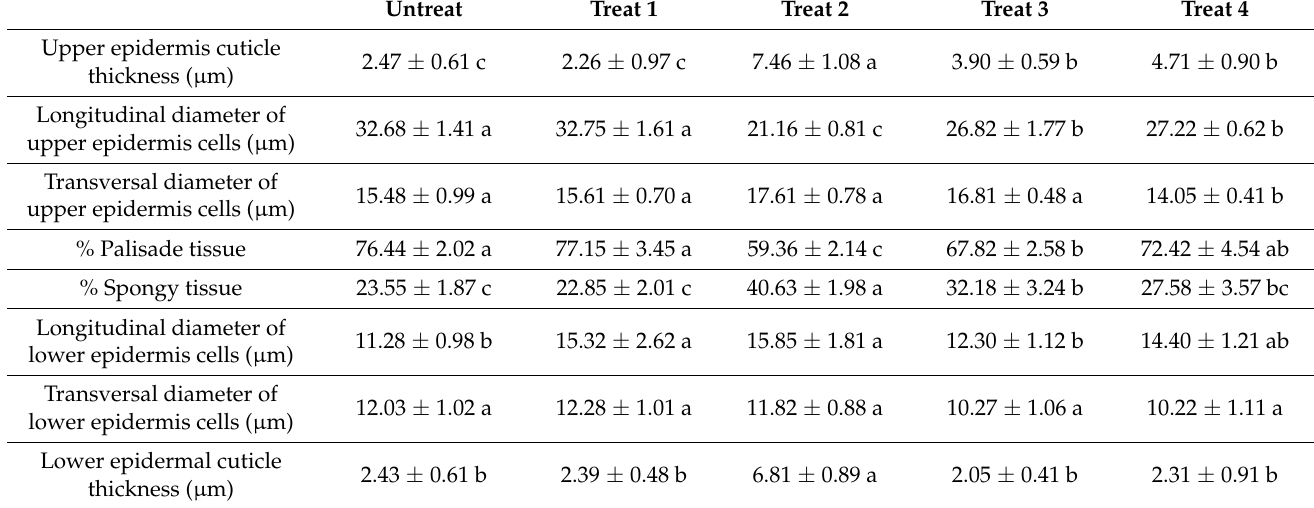
Table 4. Anatomical characteristics of hop leaves for each fertilizer plan. In rows, different letters indicate statistical differences at p < 005 with Tukey’s